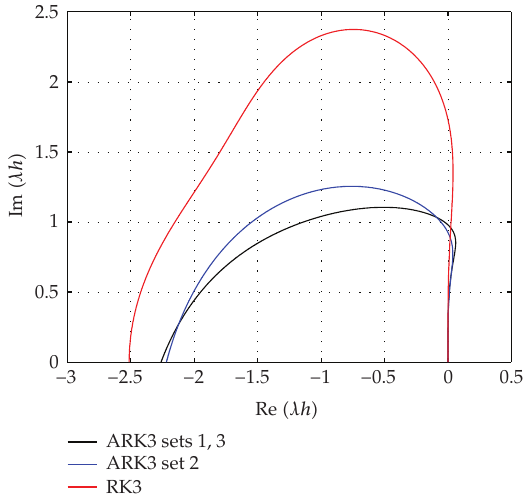
Figure 15: Stability region of ARK3 sets of Table 1 and RK3 set of Table 5.